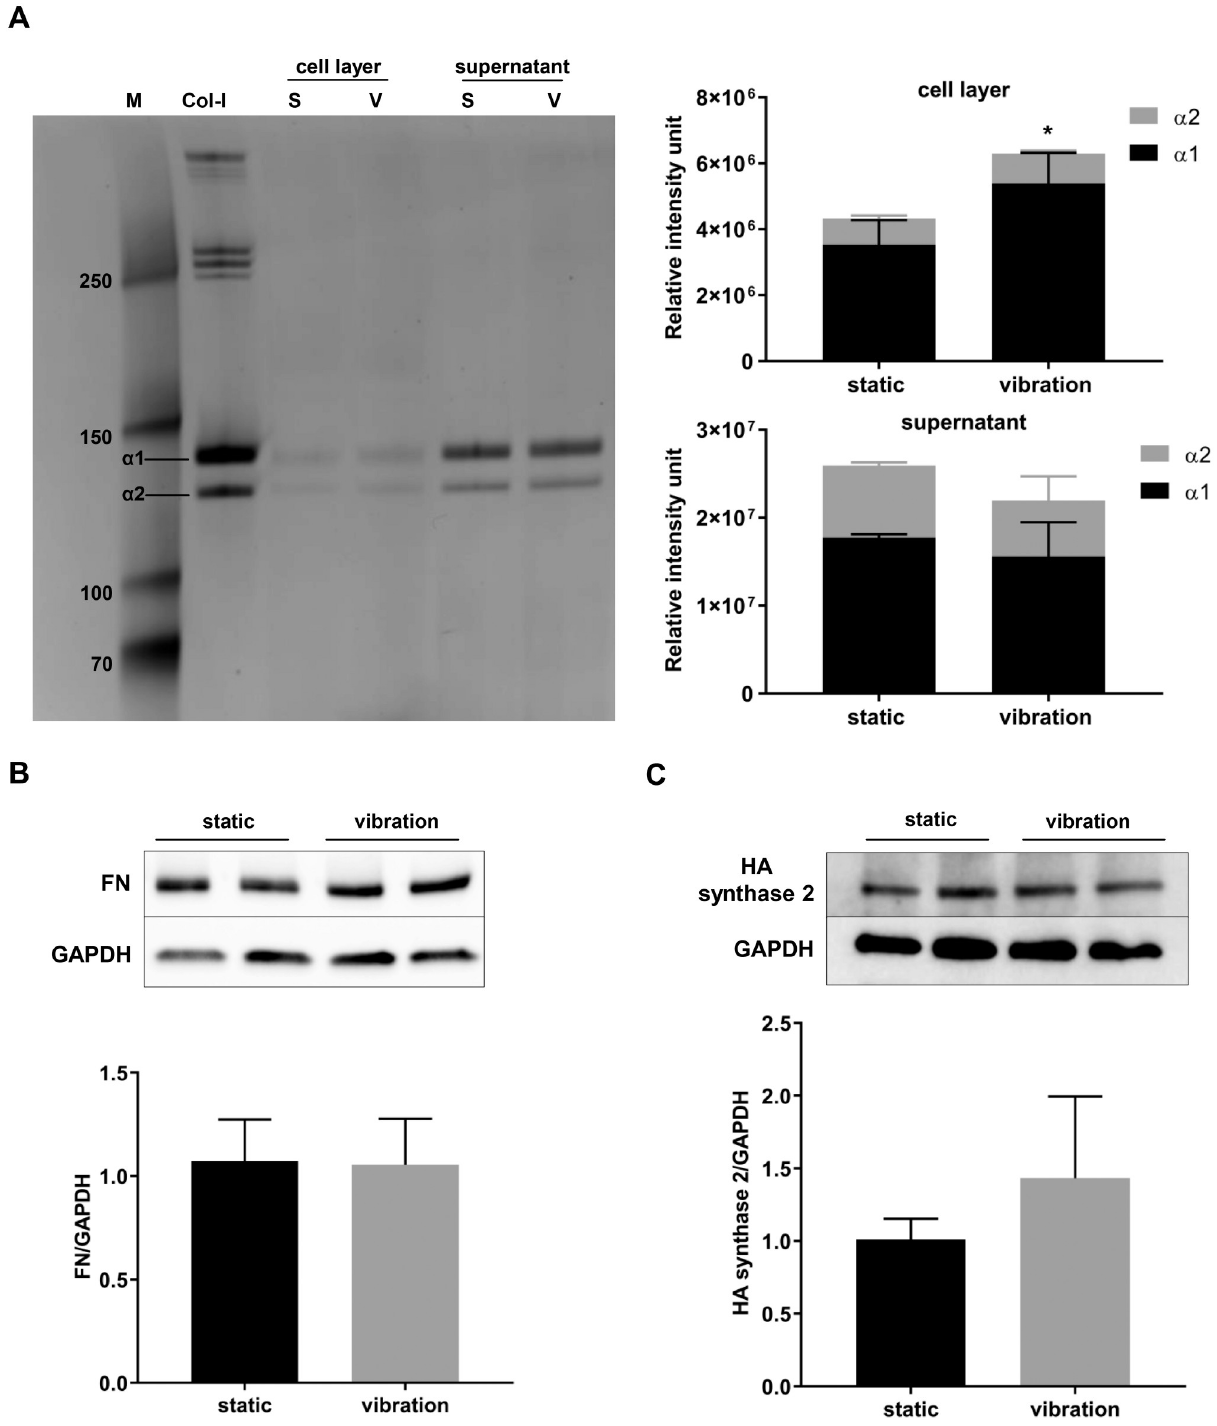
Fig 4. Effect of vibration on ECM-related protein synthesis. Supernatants and cell layers were digested with pepsin for two hours, or cells layers were lysed with RIPA buffer. Pepsin digested samples were subjected to SDS-PAGE and proteins were stained with silver (A). Proteins isolated in RIPA buffer were subjected to SDS-PAGE and Western blot, after which fibronectin (B) and HA synthase 2 (C) were detected with specific antibodies. GAPDH was used as a loading control. The values are mean ± SD of three experiments performed in duplicates and analysed by a Student’s t-test; � p < 0.05.